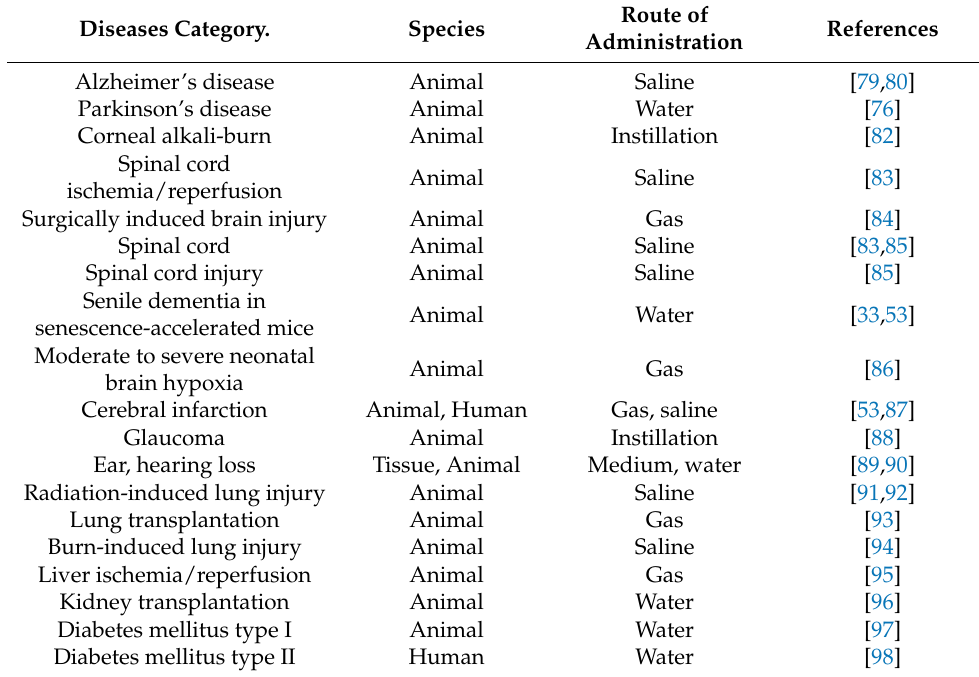
Table 1. Beneficial effects of H 2 against animal and human disease. Diseases